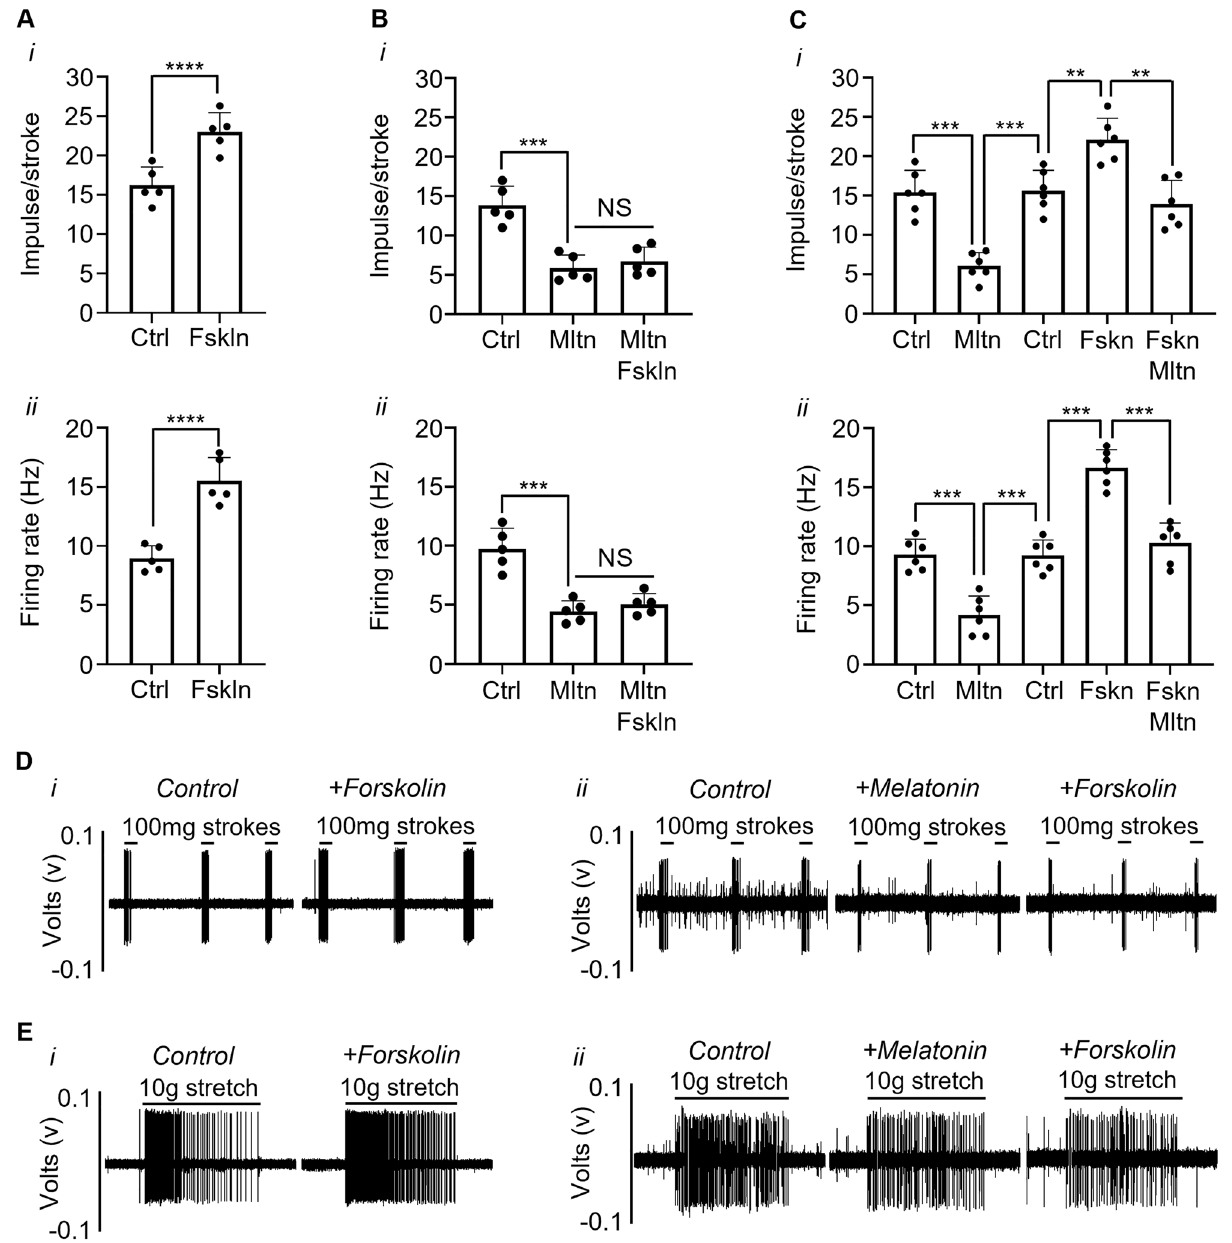
Figure 4. Melatonin prevents forskolin-induced increase in mechanosensitivity of muscular-mucosal bladder afferents. ( A ) The effect of forskolin (Fskln; 10 µM) on the responses of muscular-mucosal afferents to stroking (100 mg) ( i ) and ( ii ) stretch (10 g) in the presence of forskolin (10 µM). ( B ) The responses of muscular-mucosal afferents to ( i ) stroking (100 mg) or ( ii ) stretch (10 g) to melatonin (30 µM) alone or in the addition of forskolin (10 µM). ( C ) The response of muscular-mucosal afferents to ( i ) stroking (100 mg) or ( ii ) stretch (10 g) in the presence of forskolin (10 µM) alone or in the addition of melatonin (30 µM). Data is presented as the mean ± the SEM, N = 5–6, n = 5–6 per group. **P < 0.01, ***P < 0.001, ****P < 0.0001 vs control. ( D ) Raw traces of the response of muscular-mucosal afferents to stroking (100 mg) in ( i ) the presence of forskolin (10 µM) alone or ( ii ) in the presence of both melatonin (30 µM) and forskolin (10 µM). ( E ) Raw traces of the response of muscular-mucosal afferents to stretch (10 g) in ( i ) the presence of forskolin (10 µM) alone or ( ii ) in the presence of both melatonin (30 µM) and forskolin (10